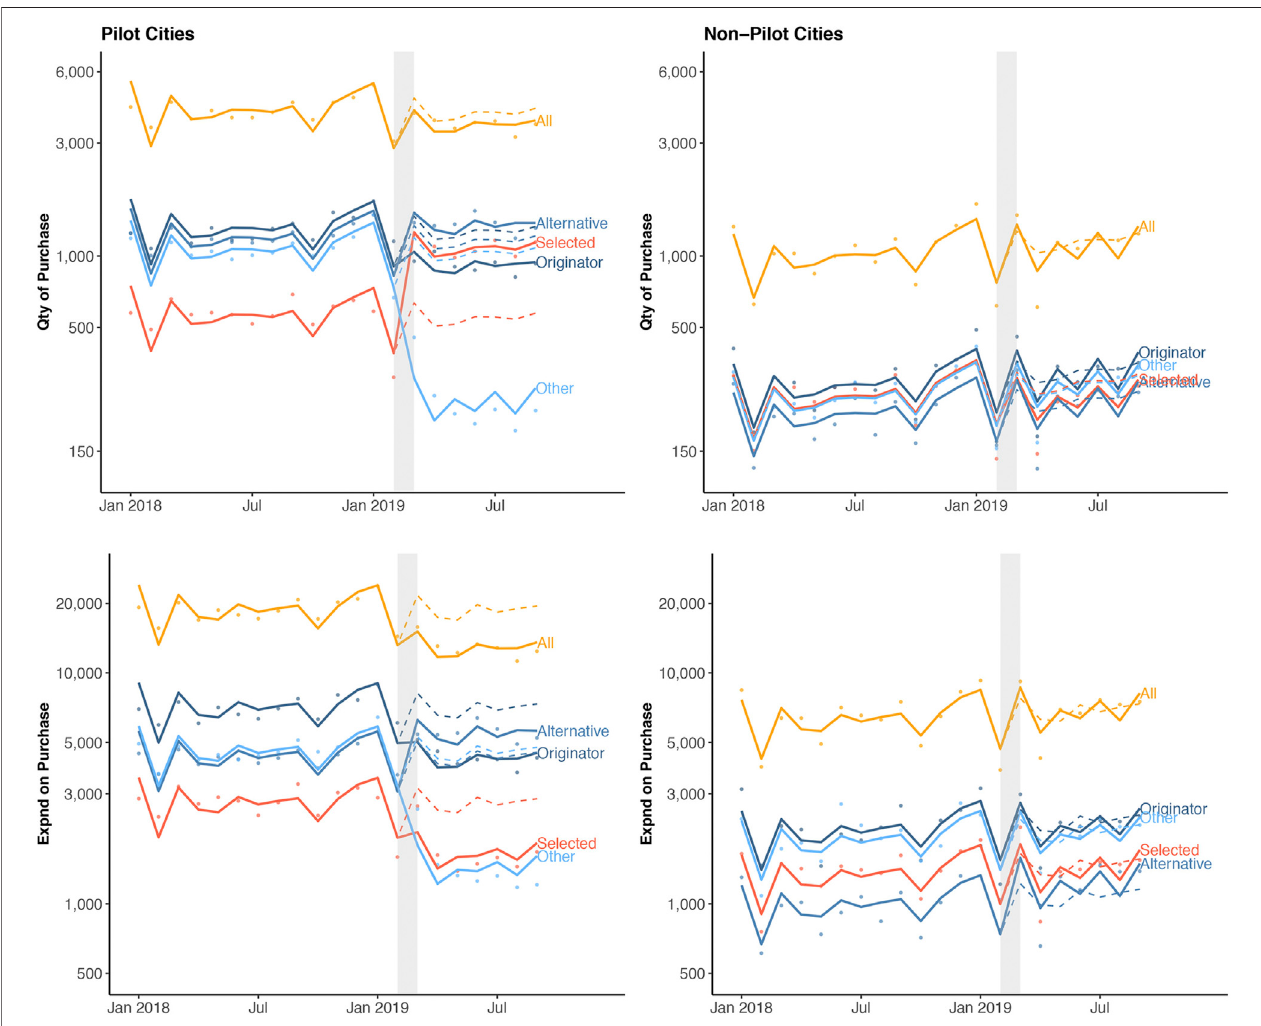
FIGURE 2 | Quantity of and spending on drug purchase strati fi ed by cities and drug categories over time. Dots indicate observed monthly purchase quantity (Qty, measured in DDD) or purchase spending (Expnd, measured in CNY) per 1, 000 population. The solid lines show the model fi tted regression line, and the dashed lines represent model-estimated expected (i.e., counterfactual) purchase had the pilot program not occurred. The observed nadir in drug purchases in a calendar year coincides with the annual lunar new year in February.